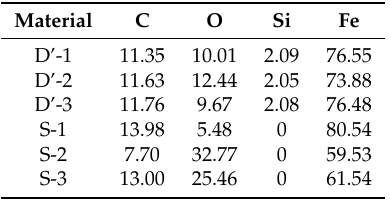
Table 6. Energy-dispersive X-ray spectroscopy (EDS) results of the worn surface of the ductile iron and